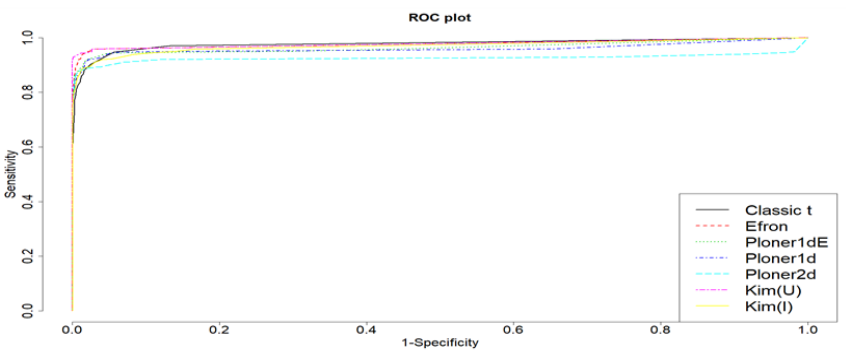
Figure 8. Mean shift scenario and two-sided. ROC curve when µ = 1.5 and cutoff values ranging from 0 to 1 with steps of